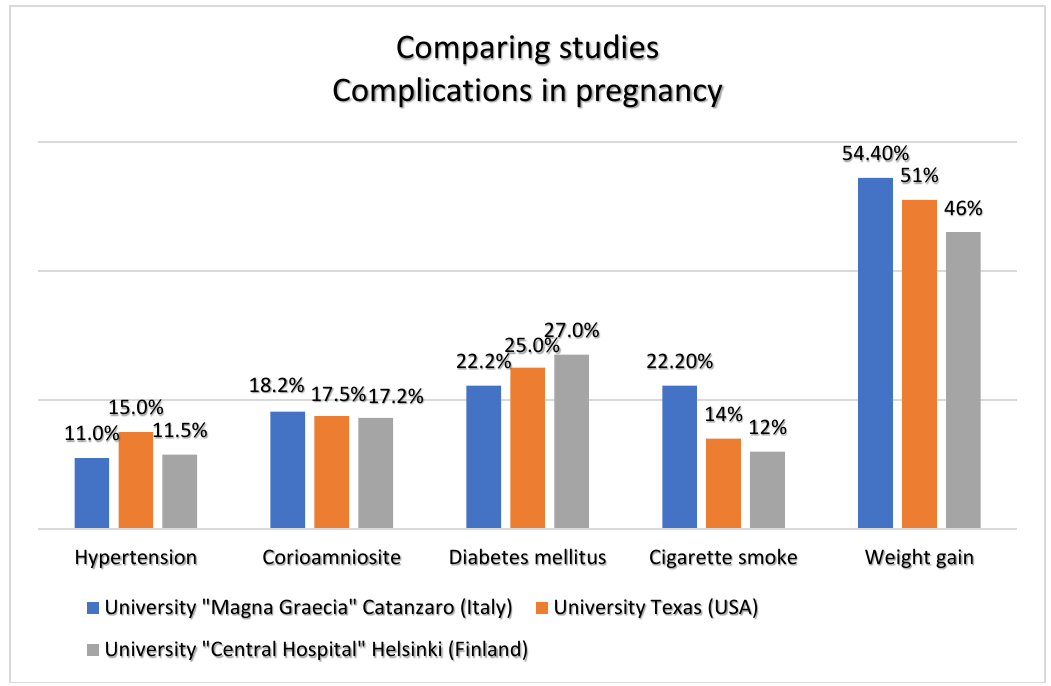
Figure 6. Comparing studies .